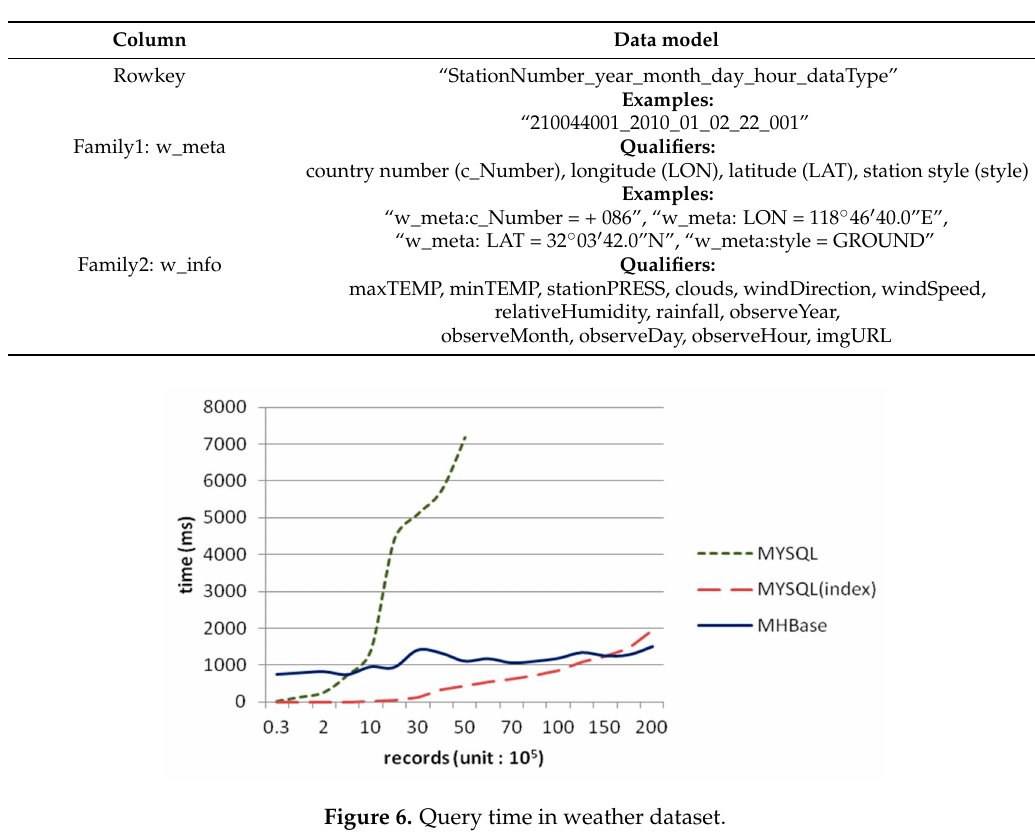
Table 3. HBase table structure of meteorological data.